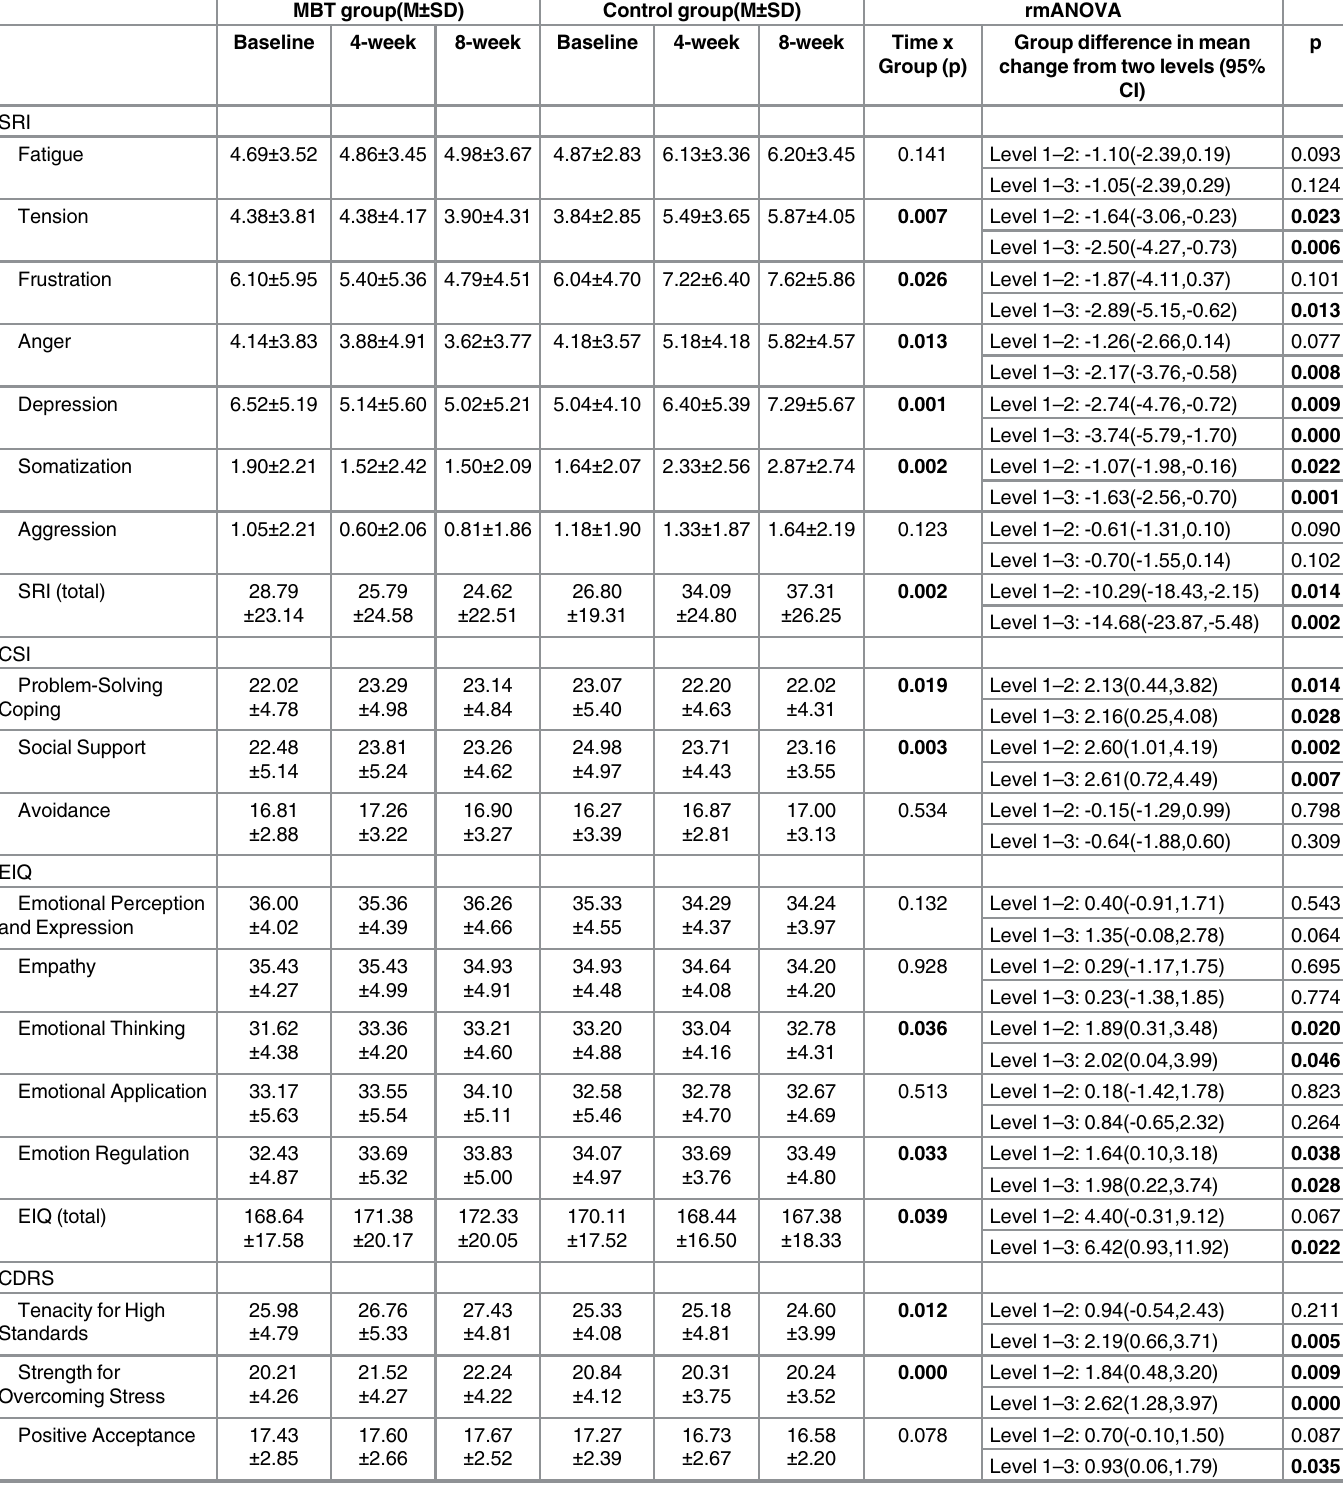
Table 2. Differences in SRI, CSI, EIQ and CDRS scale scores for the MBT and control groups at all time